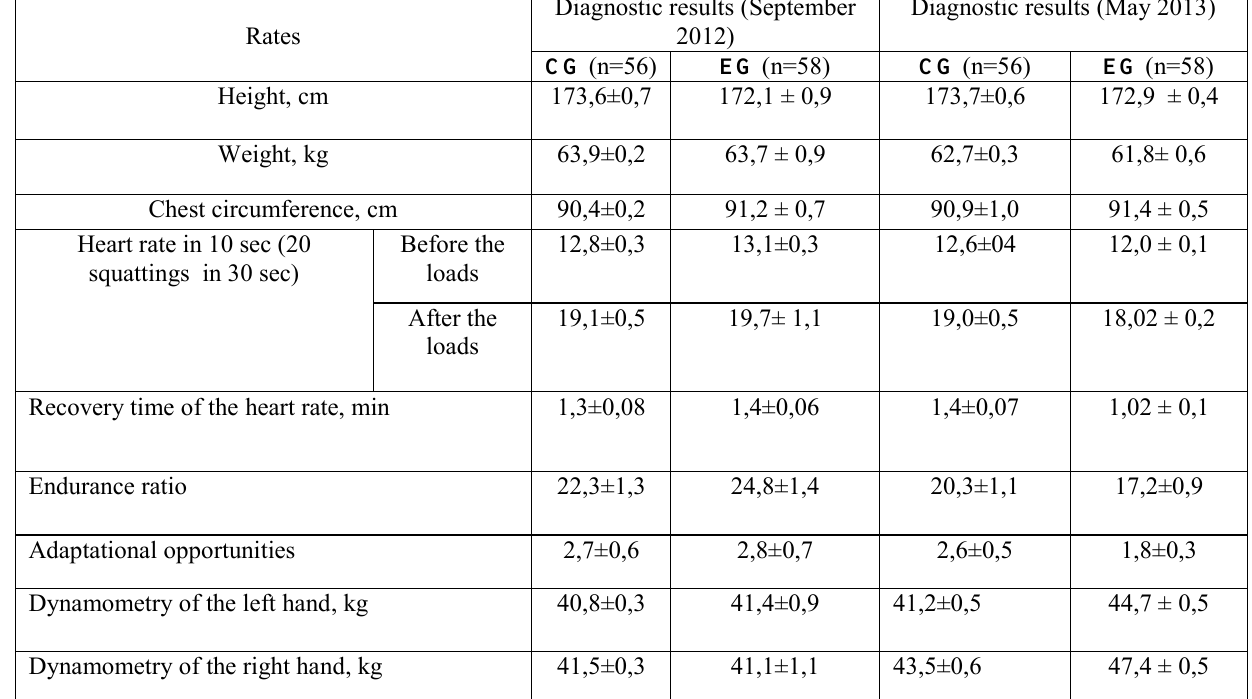
Annual dynamics of physical development and physical training of foreign students from CG and EG (M ±